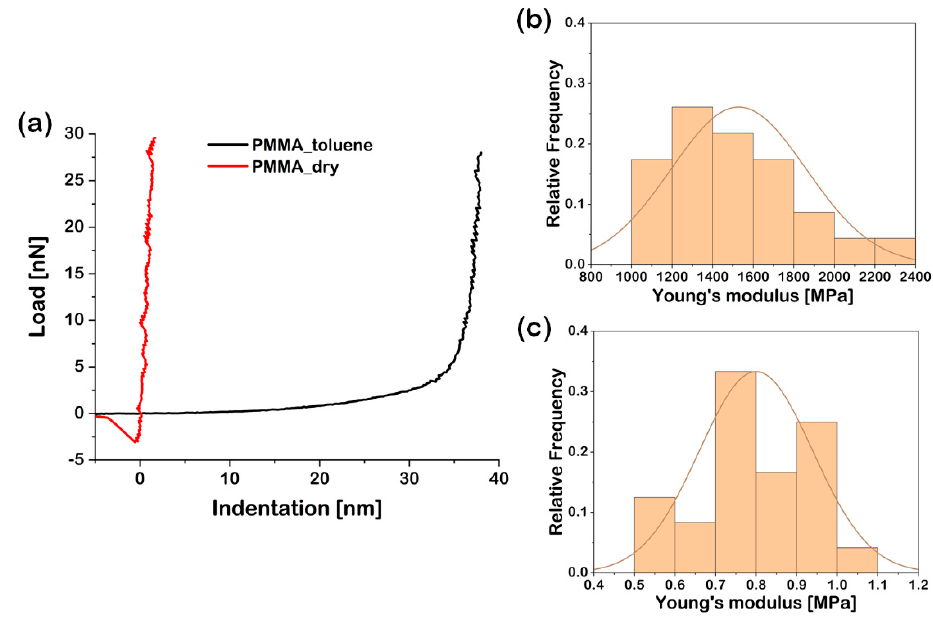
Figure 3. Exemplary AFM nanoindentation curves of ( a ) PMMA in the air and toluene with histograms showing distribution of calculated Young’s moduli for ( b ) PMMA brush in the air and ( c ) the same brush immersed in toluene.